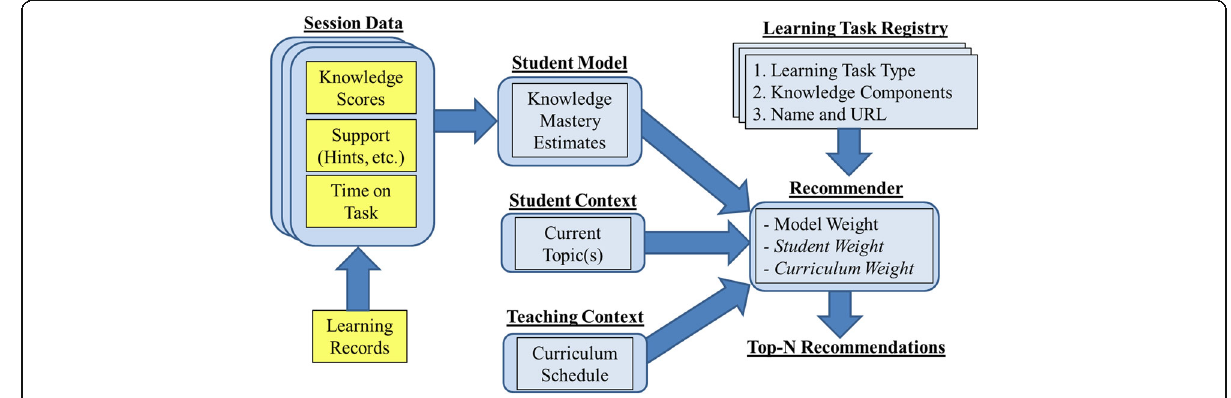
Fig. 2 Integrating student model estimates and learning task